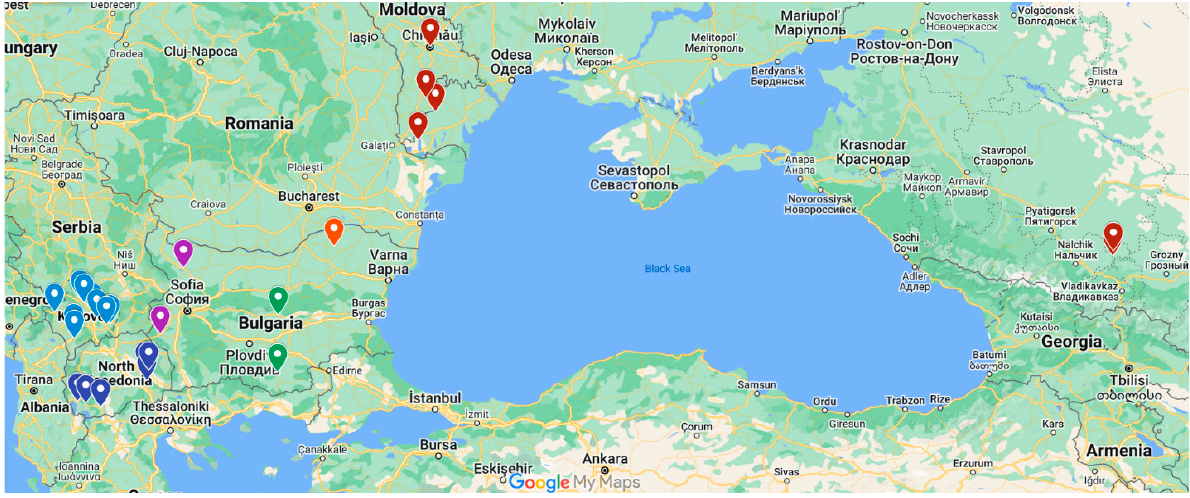
Figure 2. Dialect locales. Figure 2. Dialect Dobruja Turkish represented by Razgrad is in between East Rumelian and Kosovar Turkish I with a VX order at 38%.